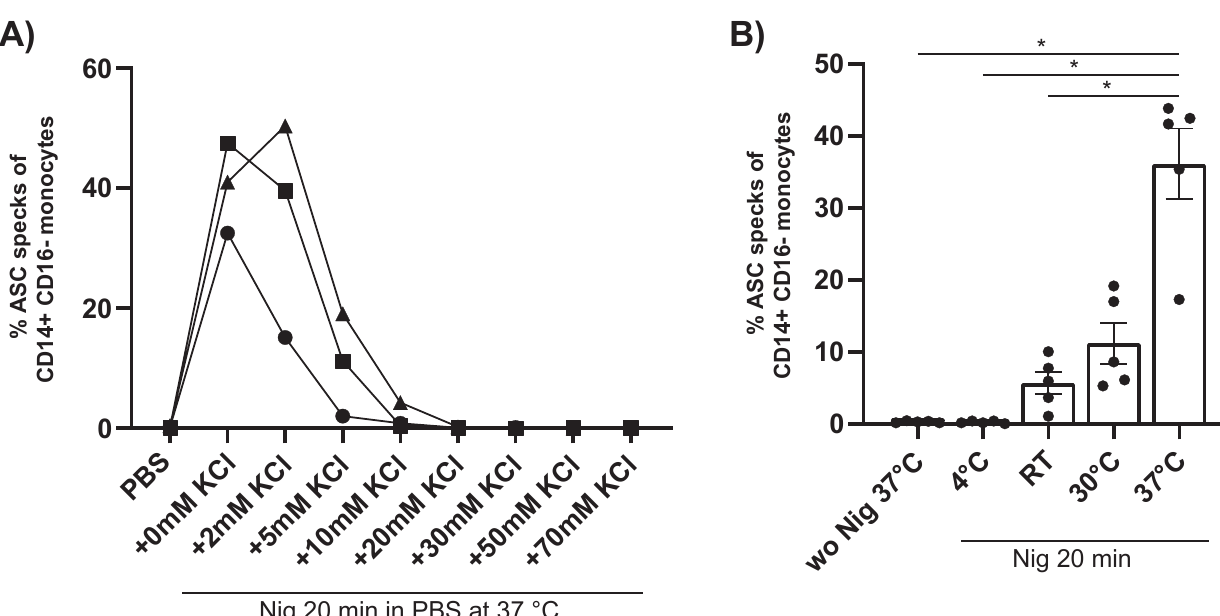
Figure 4. ASC speck formation when incubating with Nig in PBS is dependent on K + concentration and temperature. ( A ) Percentage of ASC speck + monocytes of CD14 ++ CD16 − monocytes from PBMCs left untreated or incubated with Nig in PBS. Before adding the Nig, PBS was supplemented with different concentrations of KCl. ( B ) Percentage of ASC speck + monocytes of CD14 ++ CD16 − monocytes from PBMCs left untreated or incubated with Nig in PBS at 4 ◦ C, RT, 30 ◦ C, or 37 ◦ C for 20 min. Repeated measure one way-ANOVA, followed by a Bonferroni multiple comparison test was performed. A p -Value * p < 0.05, was considered significant ( n = 3 for ( A ) and n = 5 for ( B ) measured as triplicates and represented as the mean value from these, from three different experiments, shown mean ±